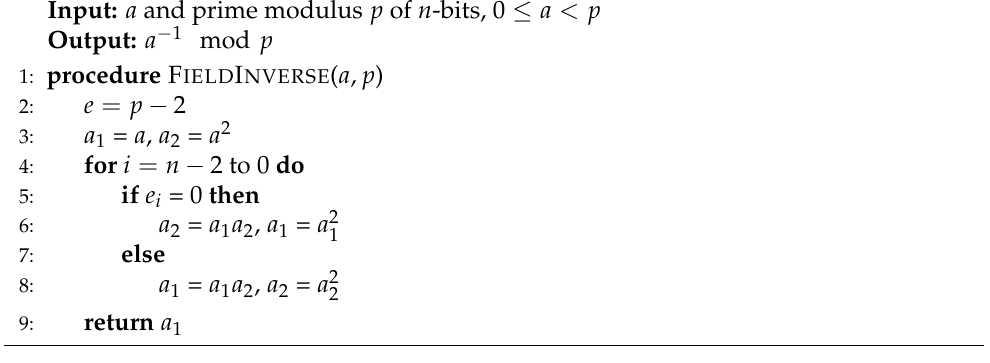
Algorithm 4 Constant-time Field Inversion algorithm